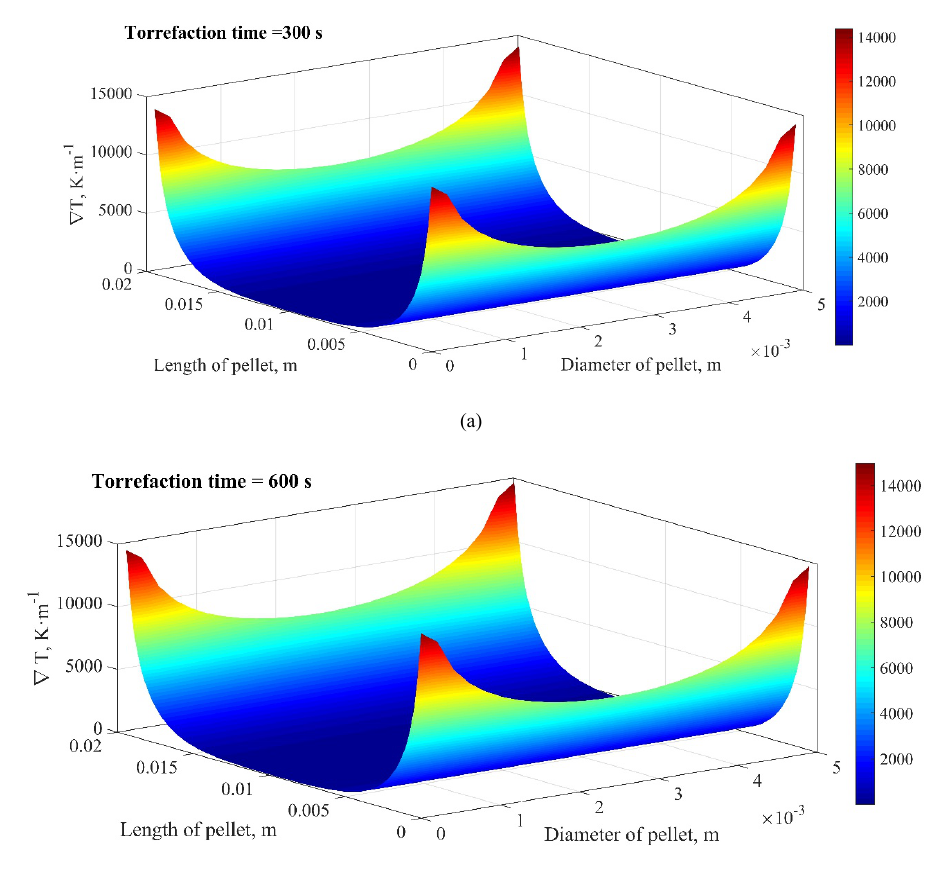
Fig. 5. The effect of varying heat flux and processing time on the temperature distribution across the pellet: a) 81.55 kW·m − 2 ; b) 84.88 kW·m − 2 ; c) 86.068 kW·m − 2